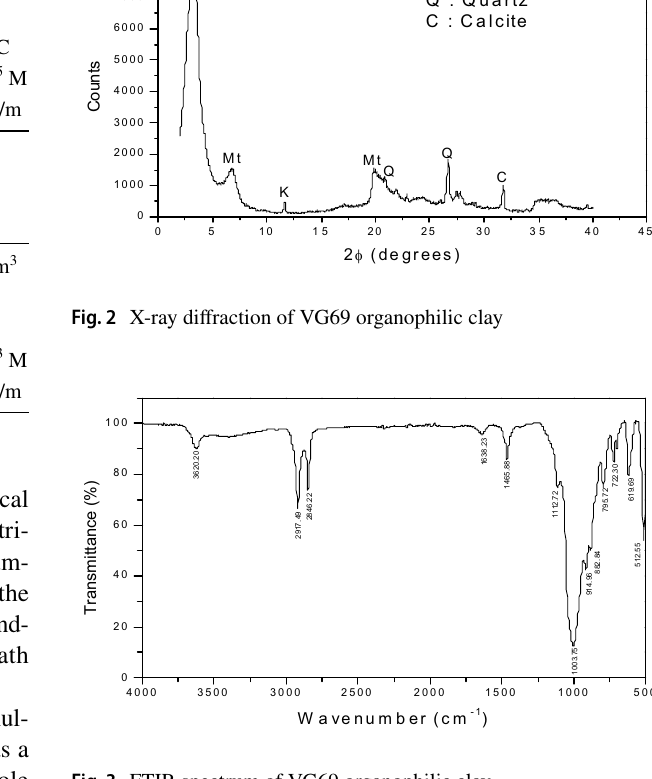
Fig. 3 FTIR spectrum of VG69 organophilic